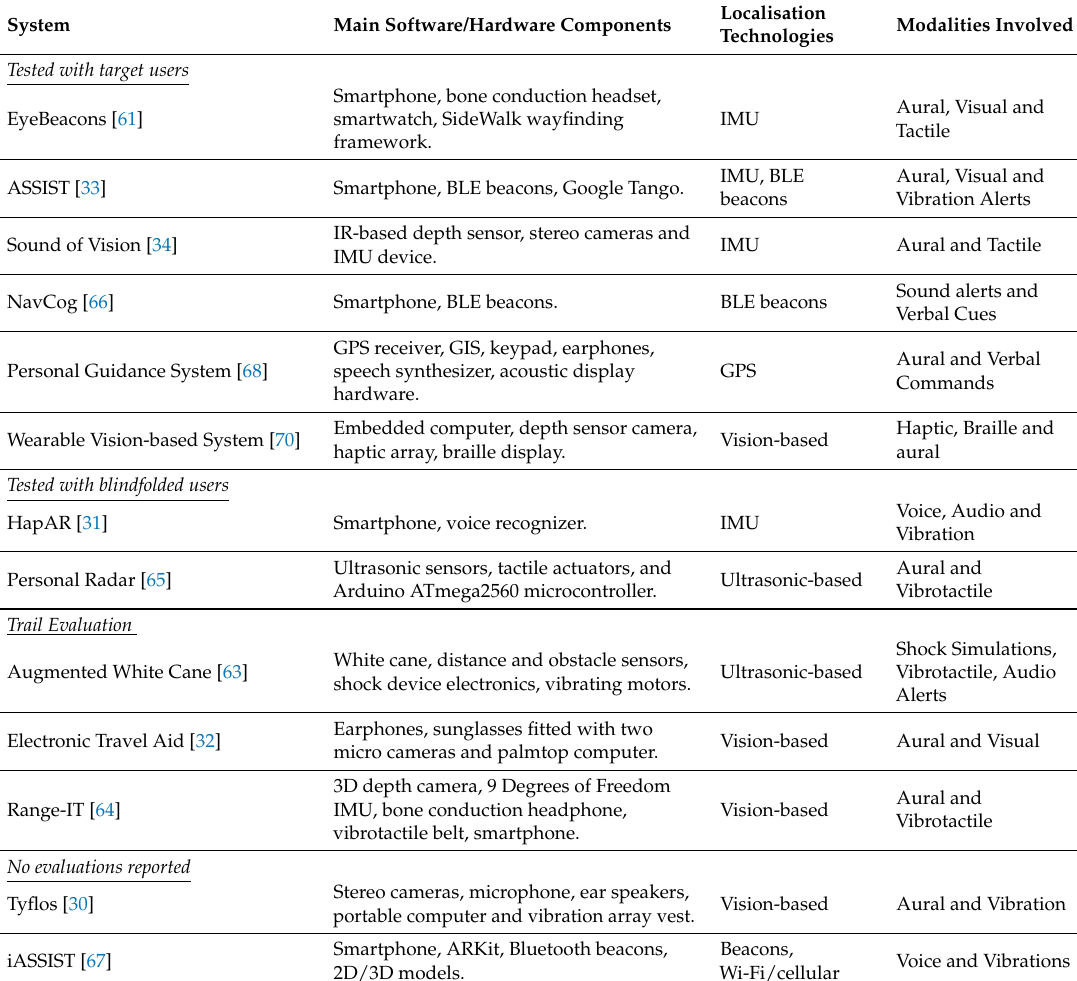
Table 1. Multimodal navigation